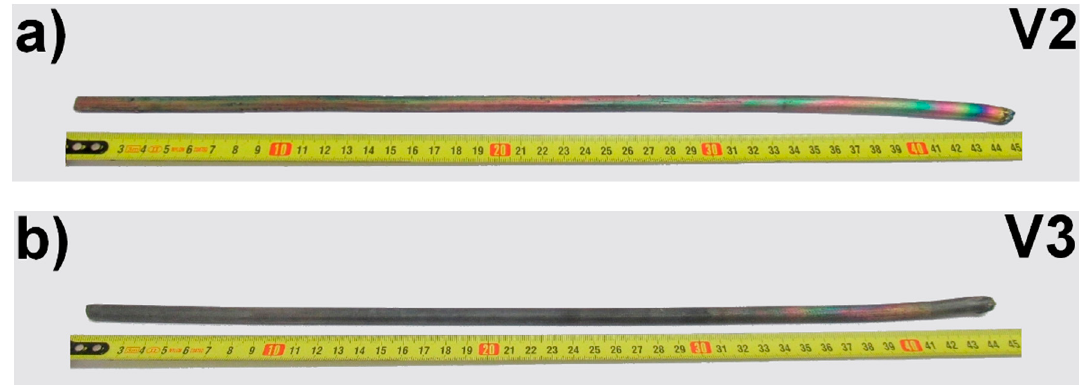
Figure 5. Example photos of final rods-products obtained by KOBO extrusion of briquettes: ( a ) variant V2 (Ti Gr4, coarse chips after turning), ( b ) variant V3 (Ti Gr4, thin chips after milling).